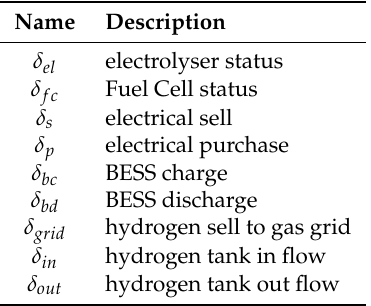
Table 2. Integer valued decision